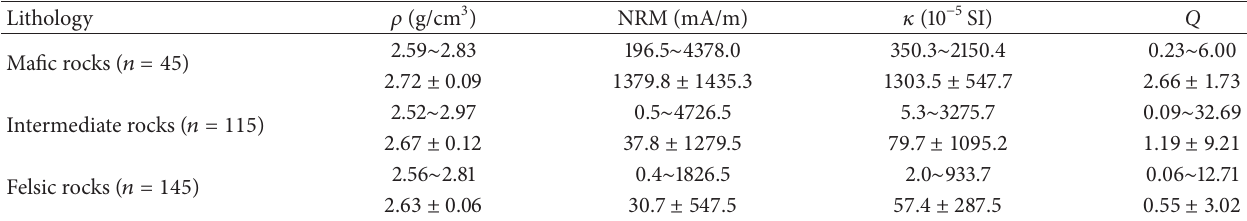
Table 3: Statistical results of 𝜌 , 𝜅 , NRM, and Q values of mafic, intermediate, and felsic igneous